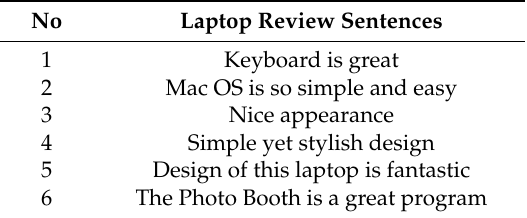
Table 1. Sample opinion review sentences (Input).